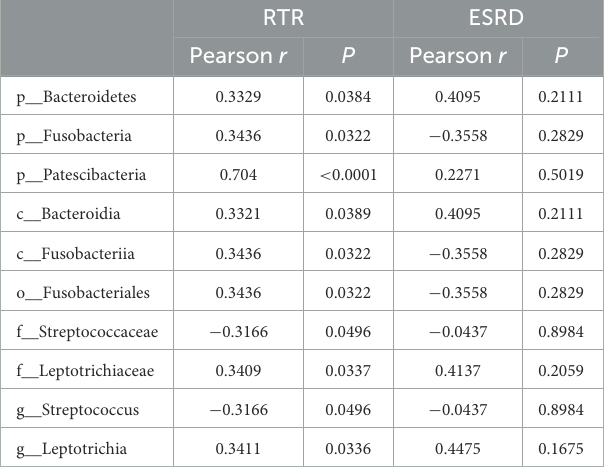
TABLE 2 Pearson correlation between the salivary microbiota and Scr after renal